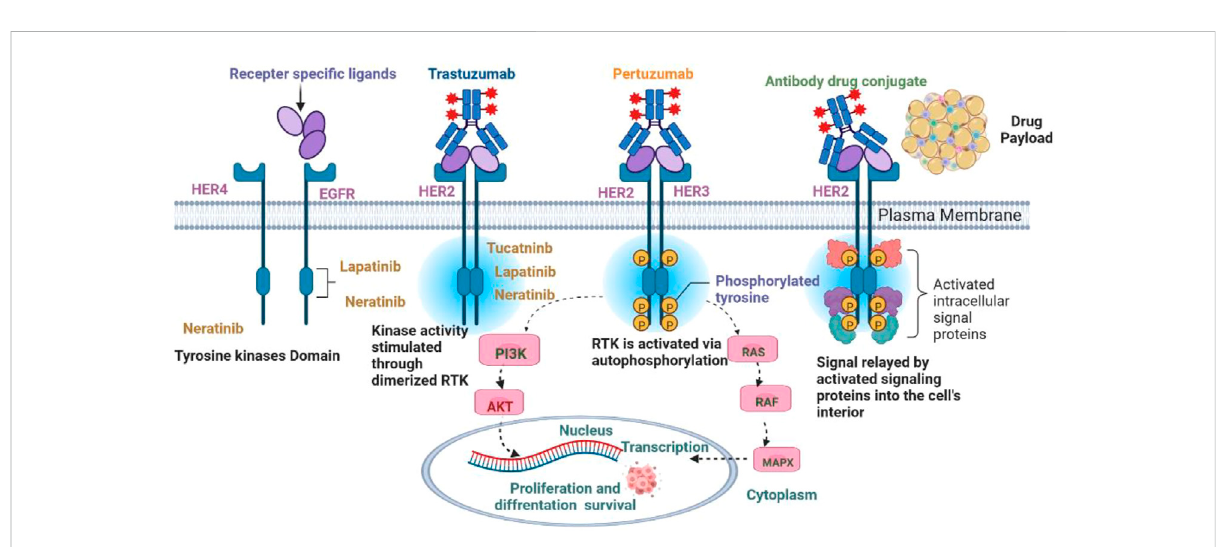
2016). Osimertinib is a third generation TKI that targets EGFR (Wang et al., 2016), Imatinib is more speci fi c for BCR- ABL mutations, more than 75 types of TKIs are used to treat various types of cancer, and most of them are under clinical